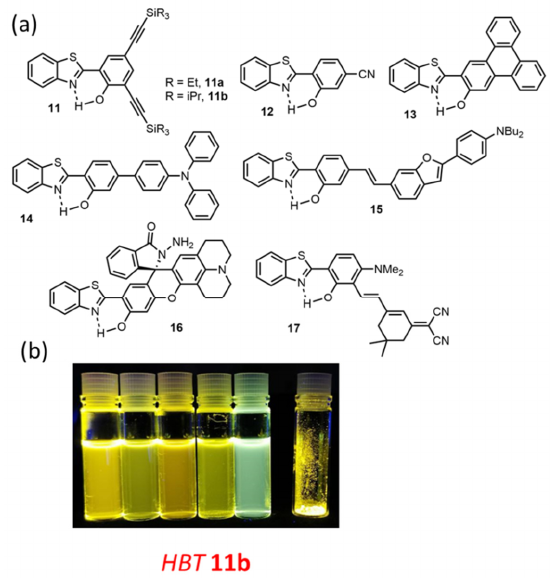
Figure 5. ( a ) Examples of HBT dyes showing DSE properties [62,69,73–78]. and ( b ) Photographs of HBT dye 11b under irradiation in solution (toluene, ethanol, THF, acetonitrile and DMF) and as powders ( λ exc = 365 nm) [62]. Adapted from ref [62] Copyright 2021 John Wiley and Sons.